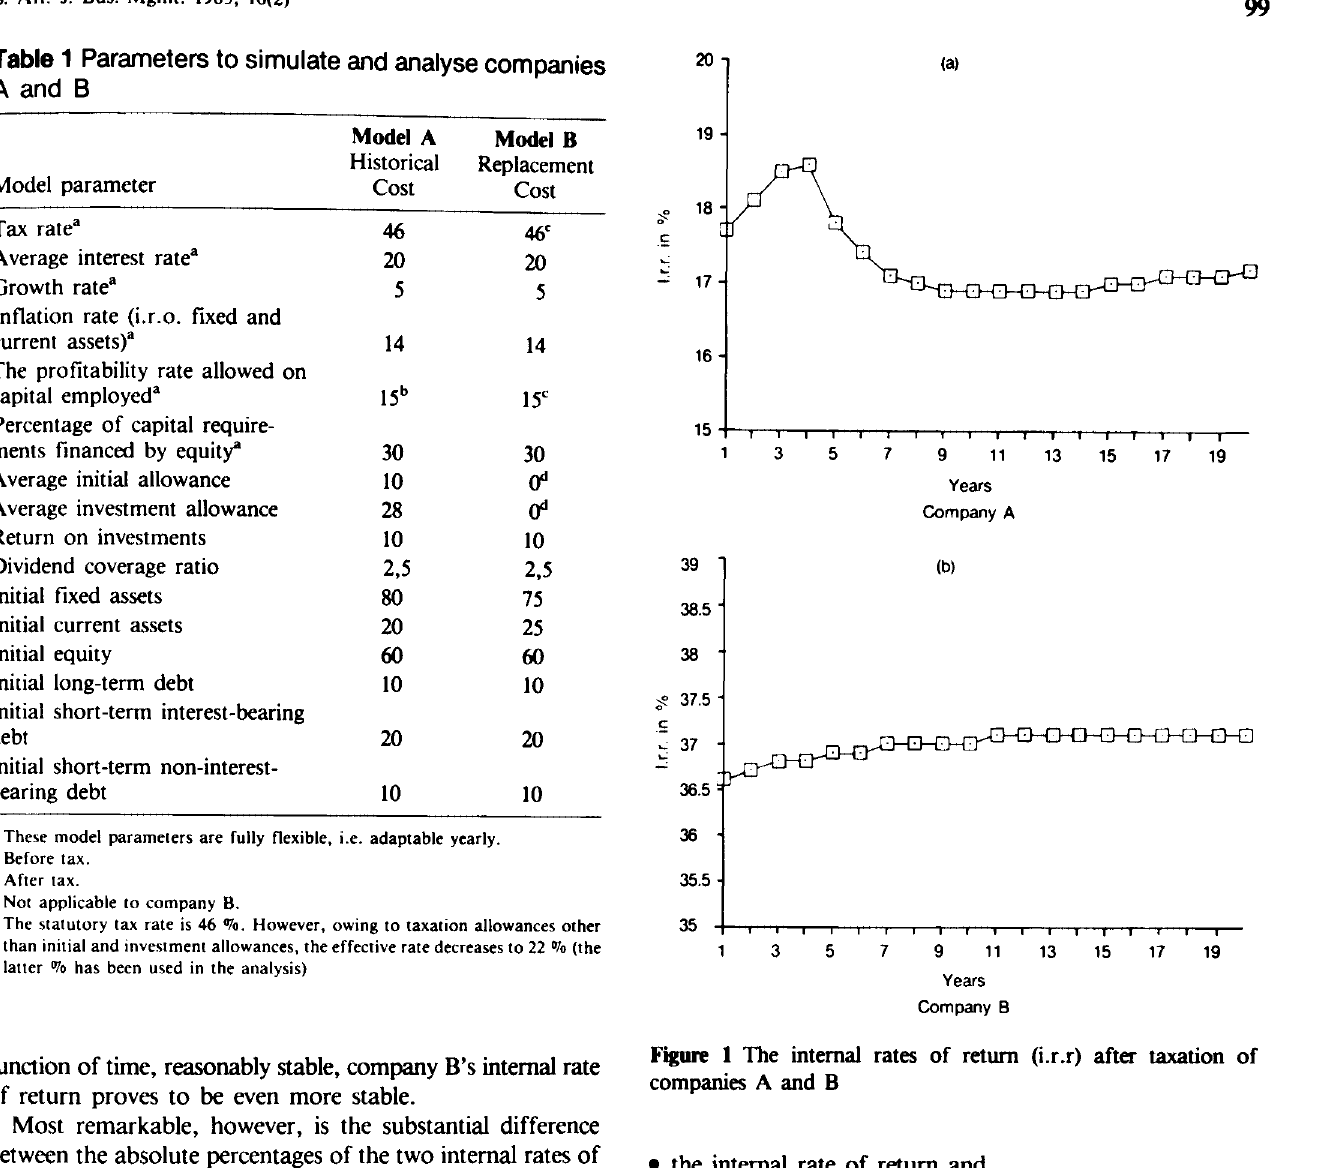
Figure 1 The internal rates of return (i.r .r) after taxation of companies A and